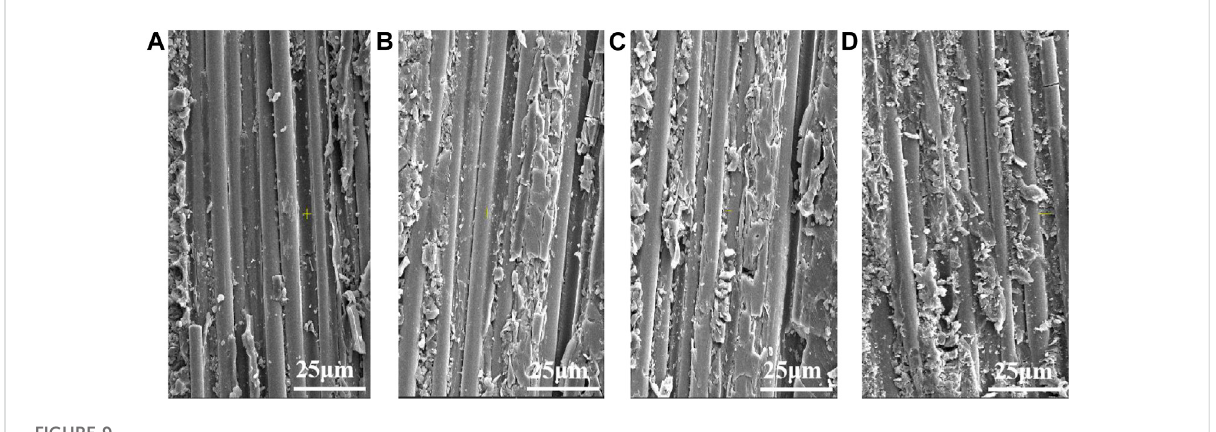
FIGURE 9 The SEM images of fracture surface in short-beam shear tests of laminates cured at 127 ° C for various time (A) for 1 h; (B) for 2 h; (C) for 3 h; (D) for 4 h.